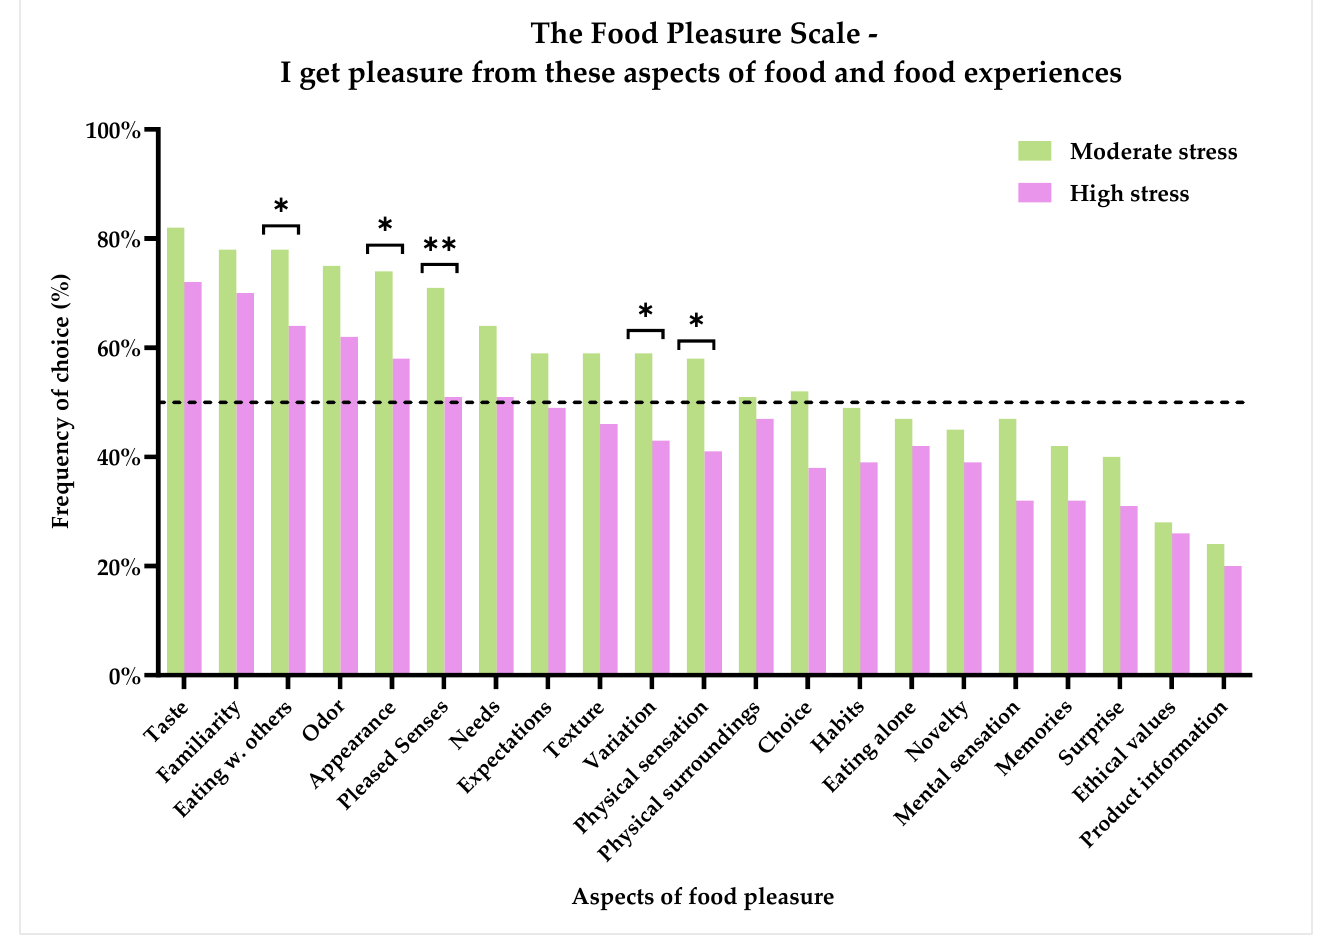
Figure 4. Subjective perception of pleasure from food and food experiences by the 21 different pleasure aspects of the Food Pleasure Scale. Results are shown for the two groups based on the results of the PSS-10: ‘Moderate stress’ ( n = 116) and ‘High stress’ ( n = 74). Stars indicate level of significance of p -values. *: p < 0.05, **: p < 0.01. Dotted line marks 50% frequency.